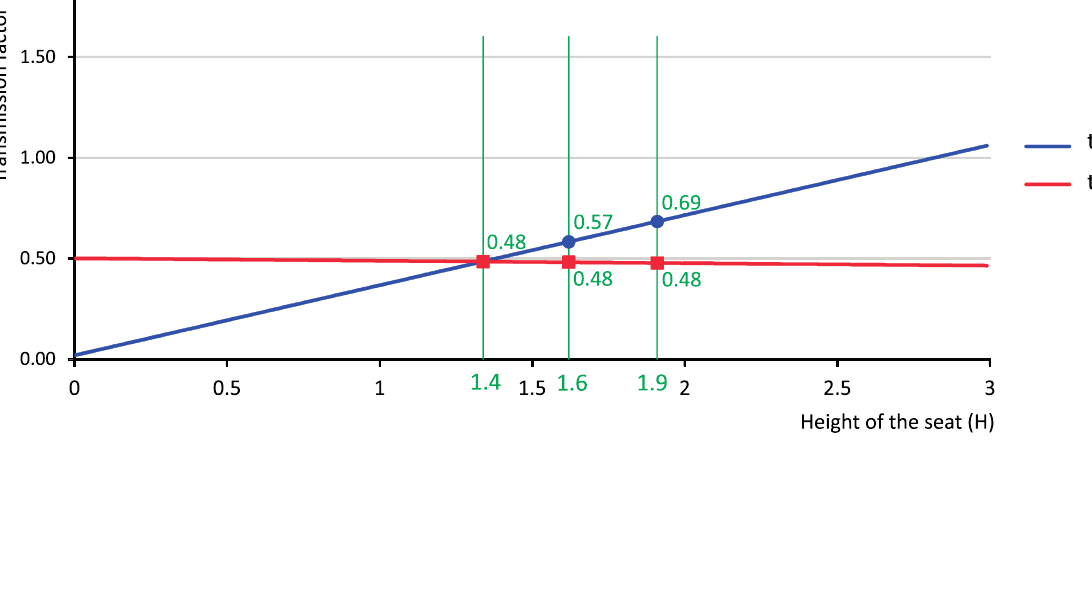
Figure 6. Transmission factor on the z and the y -axis (tf y and tf y ) of the graph as a function of tractor-seat height above the ground. The graph was computed for a Wheel Position vertical displacement of Δ WP z = 0.1 m and for a tractor with an end-to-end rear-axle width of 2.87 m. The tractor-seat height of 1.9 m above the ground in this test is represented by a vertical line, and the transmission factor on the z and the y -axis, 0.48 and 0.66, respectively, are labeled on this line. Another vertical line represents the tractor-seat height at 1.4 m, a height at which the transmission factors on the z and y -axis are equalized, the value of which is